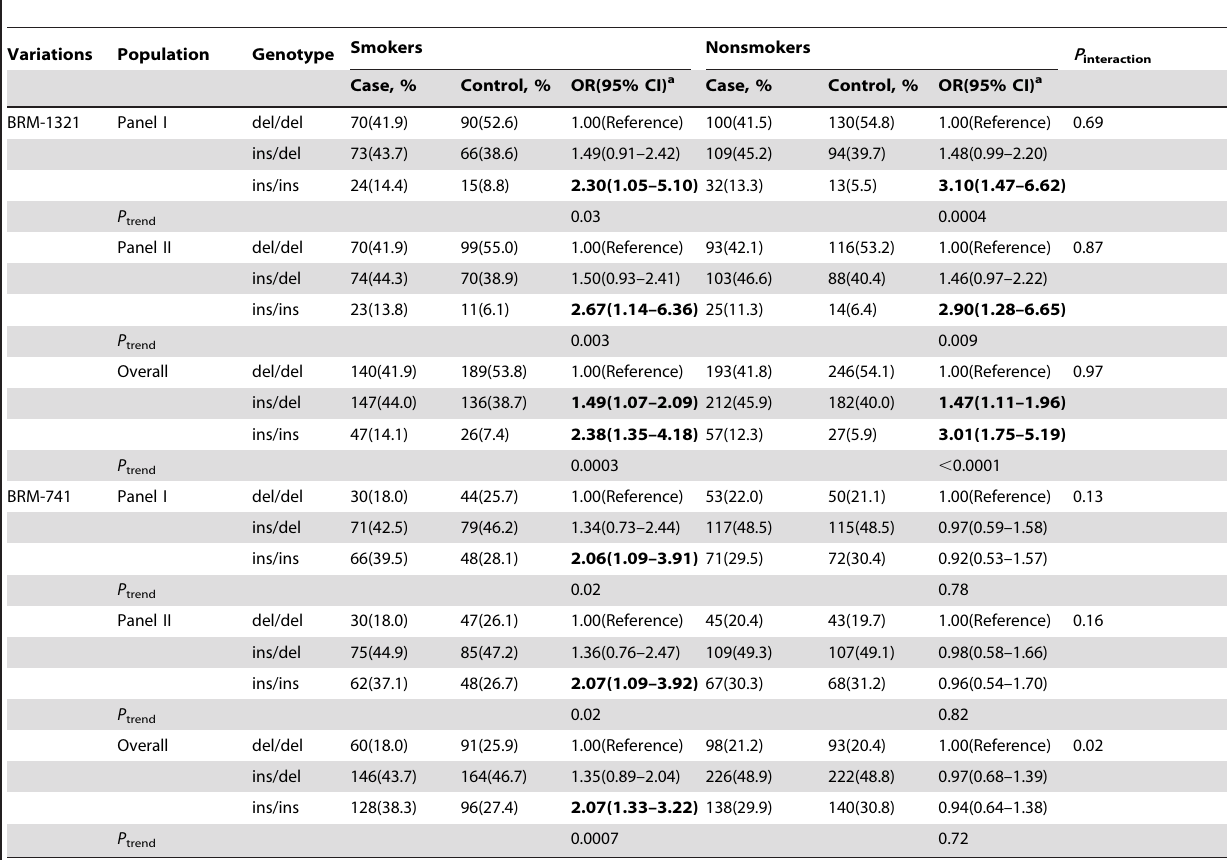
Table 3. Stratification analysis based on smoking status in two